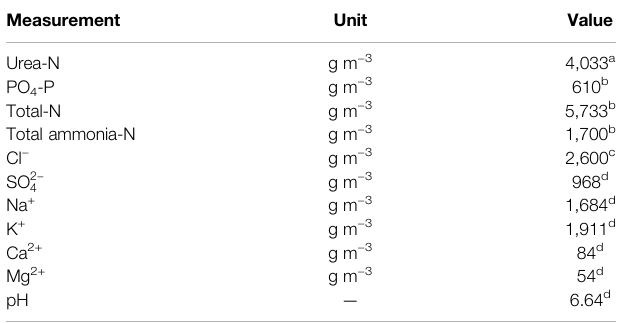
TABLE 2 | Composition of the urine used in the study for modeling the chemical speciation.